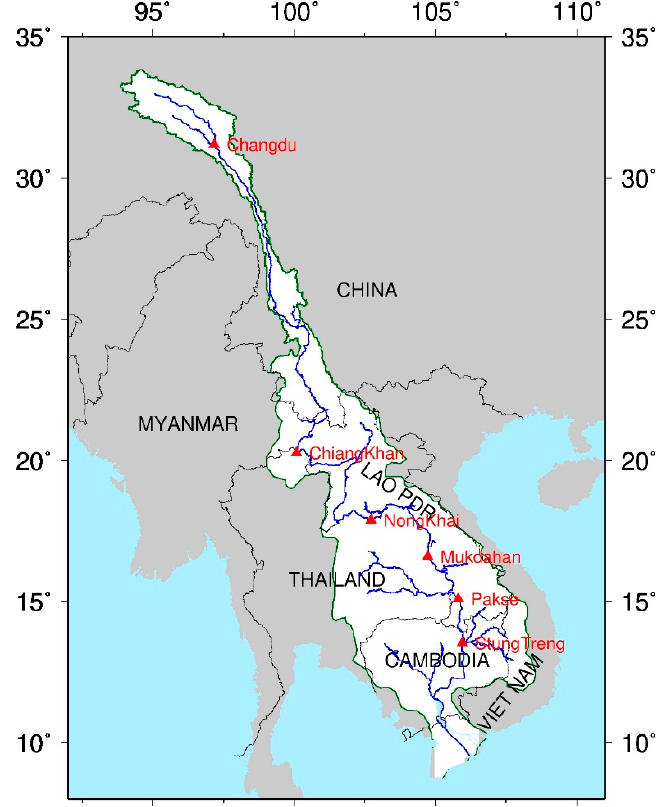
Figure 2. The Lancang–Mekong River (LMR) basin and the six in situ hydrological stations (red triangles) with >20-year daily streamflow observations.